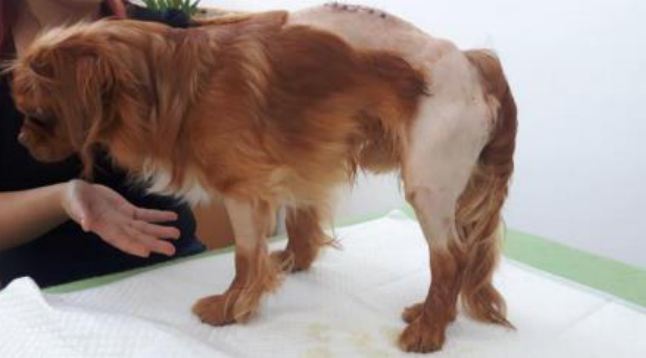
Figure 3. Inducing the standing position independently but with loss of balance.